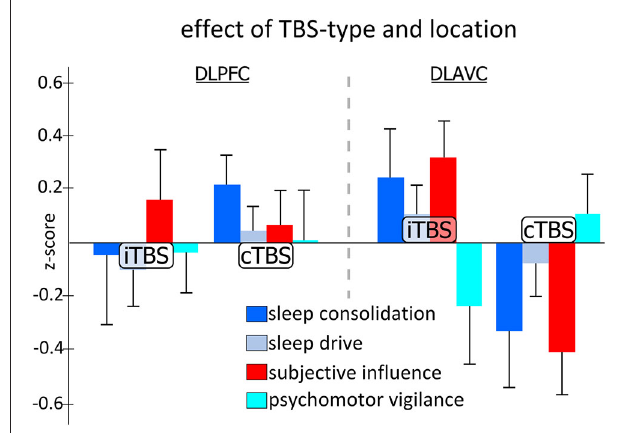
FIGURE 2 | Effect of theta-burst stimulation on aggregated categorical measures of sleep and vigilance across the two stimulation locations . Each measure represents the aggregated z -scores from various measurements taken during the experiment independent of the time of day the testing occurred. Statistical analysis indicated specific significant differences between TBS-type, either continuous TBS (cTBS) or intermittent TBS (iTBS), for stimulation of the left dorsolateral associative visual cortex (dlAVC), and also for cTBS stimulation between the dorsolateral prefrontal cortex (dlPFC) and dlAVC, for both measures of sleep consolidation and subjective influence. Error bars indicate the standard error for each measure at each location and TBS-type independently.